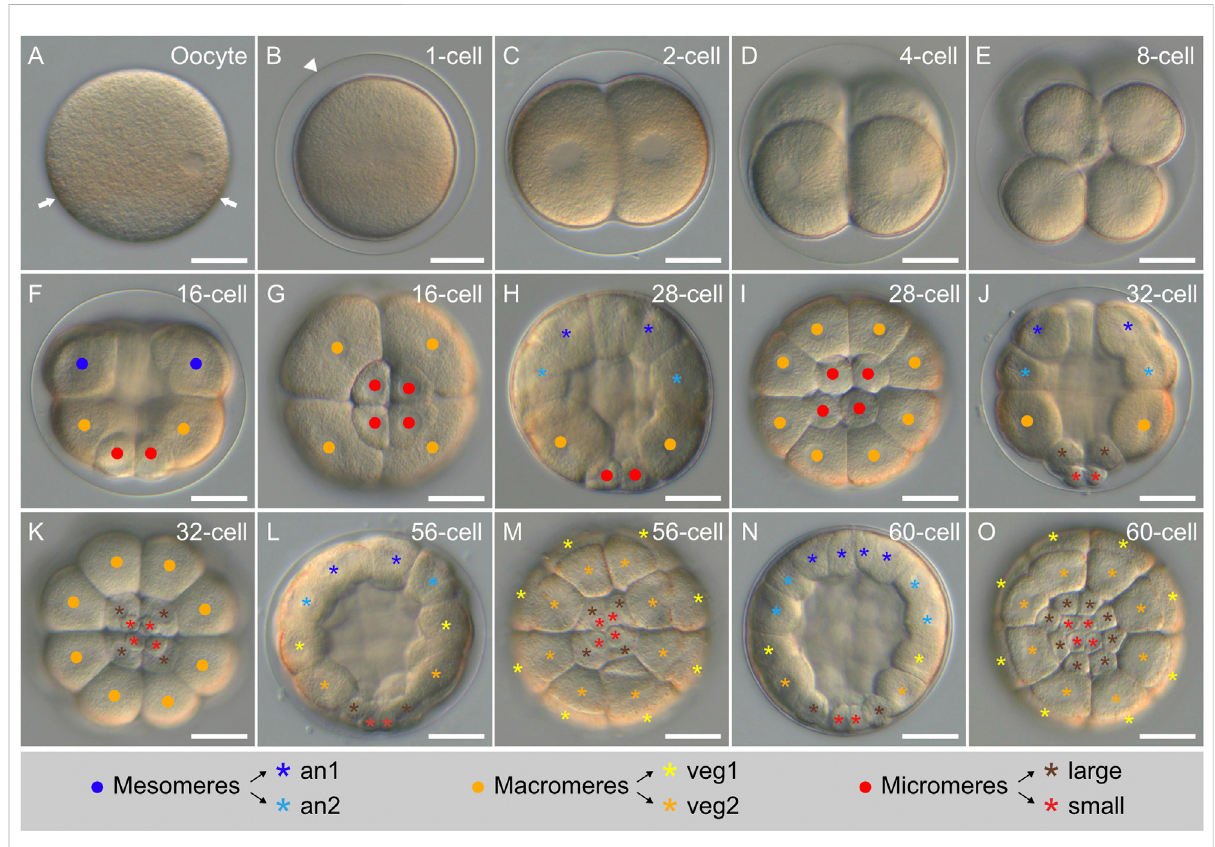
FIGURE 4 Earlycleavagestagesof Paracentrotuslividus underlightmicroscopy.Developmentalstagesareasfollows: (A) unfertilizedegg(oocyte); (B) zygote (or1-cellstage)(1-cell); (C) 2-cellstage(2-cell); (D) 4-cellstage(4-cell); (E) 8-cellstage(8-cell); (F,G) 16-cellstage(16-cell); (H,I) 28-cellstage(28-cell); (J,K) 32-cell stage (32-cell); (L,M) 56-cell stage (56-cell); (N,O) 60-cell stage (60-cell). In (A – F,H,J,L,N) , the embryos are in lateral view with the animal pole up. In (G,I,K,M,O) , the embryos are in vegetal view. In (A) , arrows highlight the equatorial pigment band. In (B) , the arrowhead marks the fertilization envelope. In (F – K) , dots in blue, orange, and red respectively indicate: the mesomeres, the macromeres, and the micromeres. In (H – O) , asterisks in dark blue, light blue, yellow, orange, brown, and red respectively mark: the an1, an2, veg1, and veg2 cells as well as the large and the small micromeres. The schematic legend below the images illustrates cell lineage relationships. Scale bar: (A – O) 30 μ m. an: animal; veg: